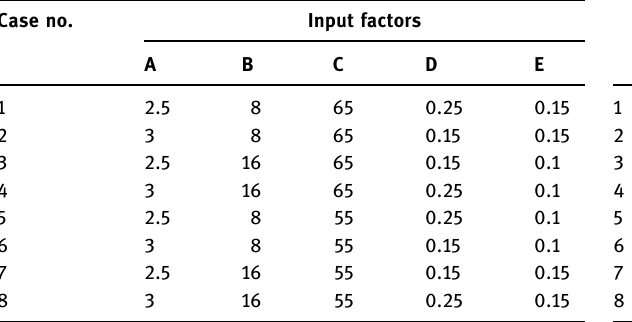
Table 3: Scheme of orthogonal experimental design Case no.